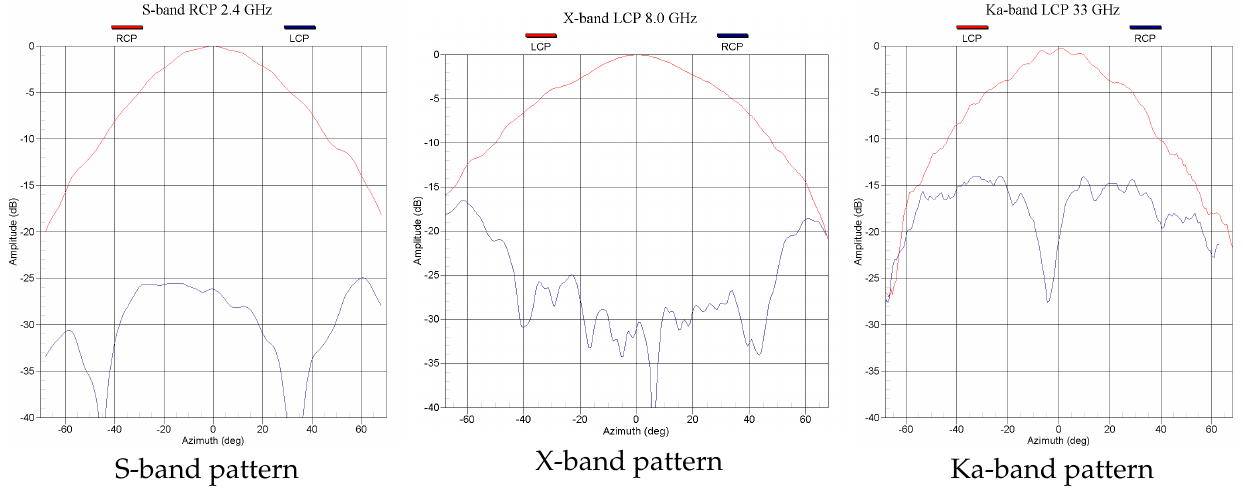
Figure 6. Measured radiation patterns of the tri-band feed in S, X and Ka bands.